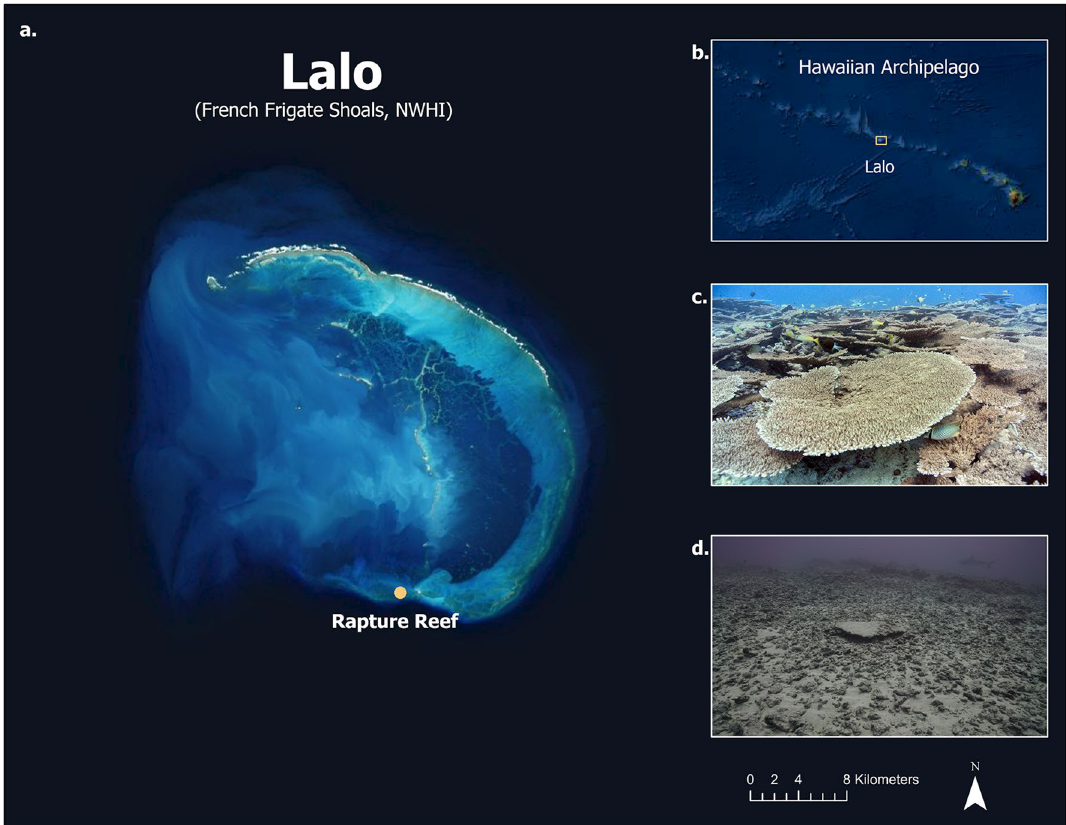
Figure 1. Aerial imagery of ( a ) Rapture Reef, Lalo (French Frigate Shoals) within the Northwestern Hawaiian Islands. Inset map of ( b ) the Hawaiian Archipelago and Lalo’s location. Images showing coral and fish abundance at Rapture Reef ( c ) before (September 2017) and ( d ) after (July 2019) Hurricane